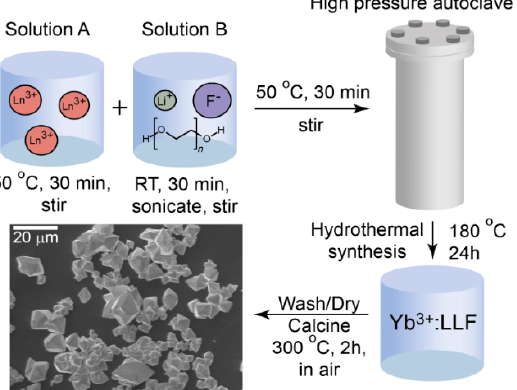
Figure 1. Schematic of the base PEG-assisted hydrothermal synthesis of Yb:LLF